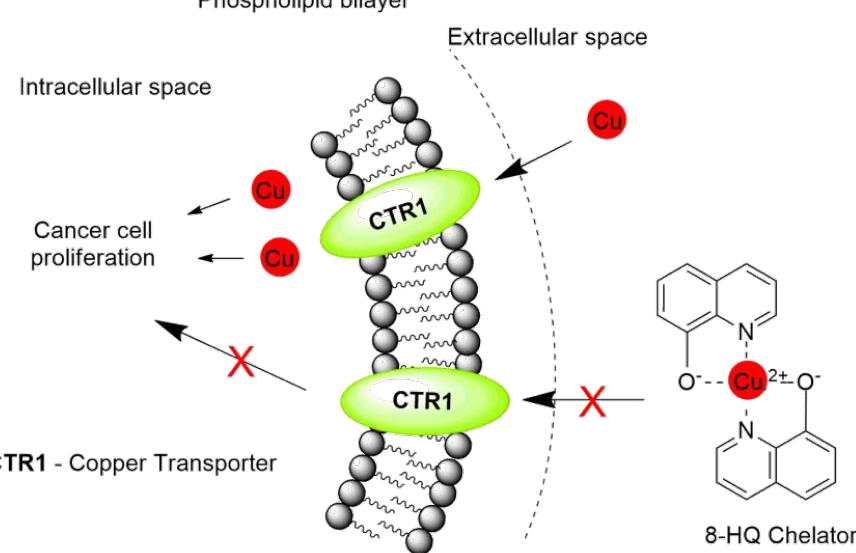
Figure 1. The concept of using metal chelators.